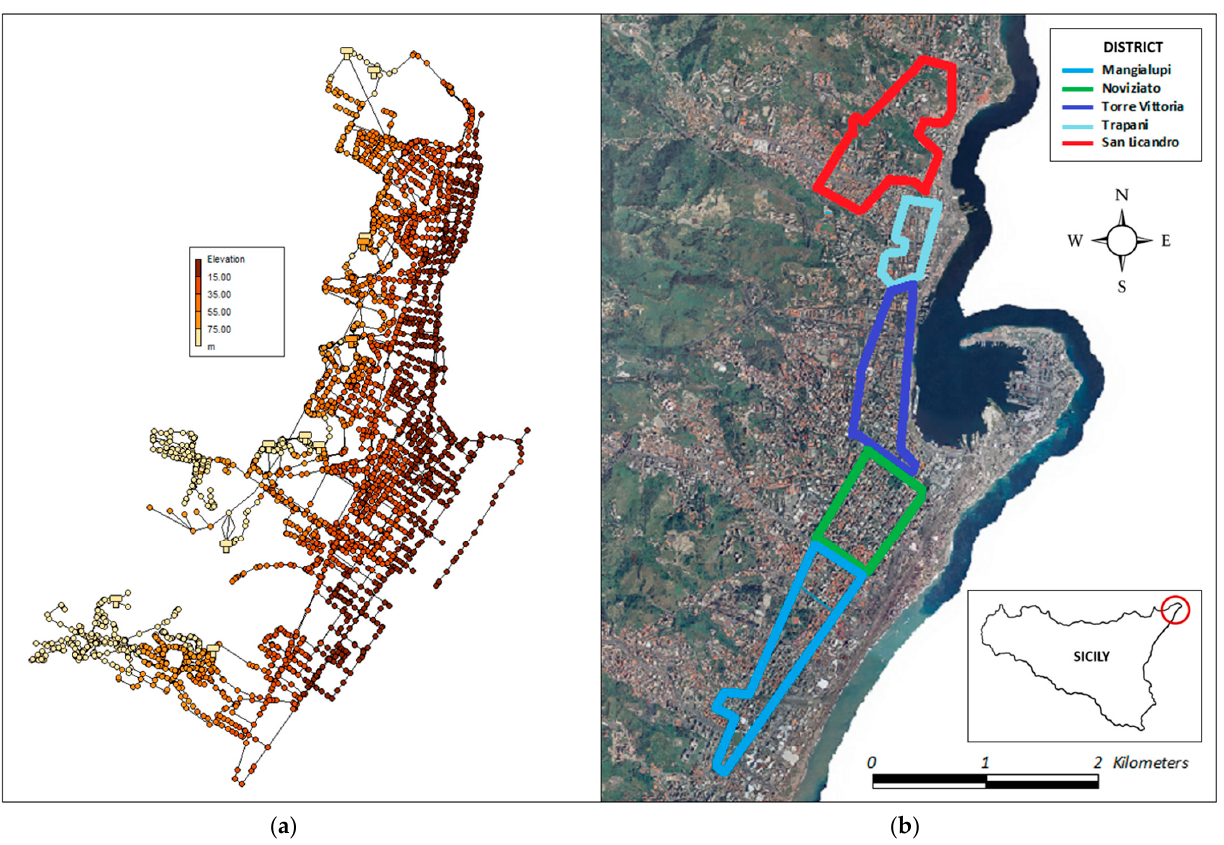
Figure 2. ( a ) Hydraulic Model of Messina WDN in EPANET with elevation values of supply junctions. ( b ) The five main districts of Messina’s WDN.